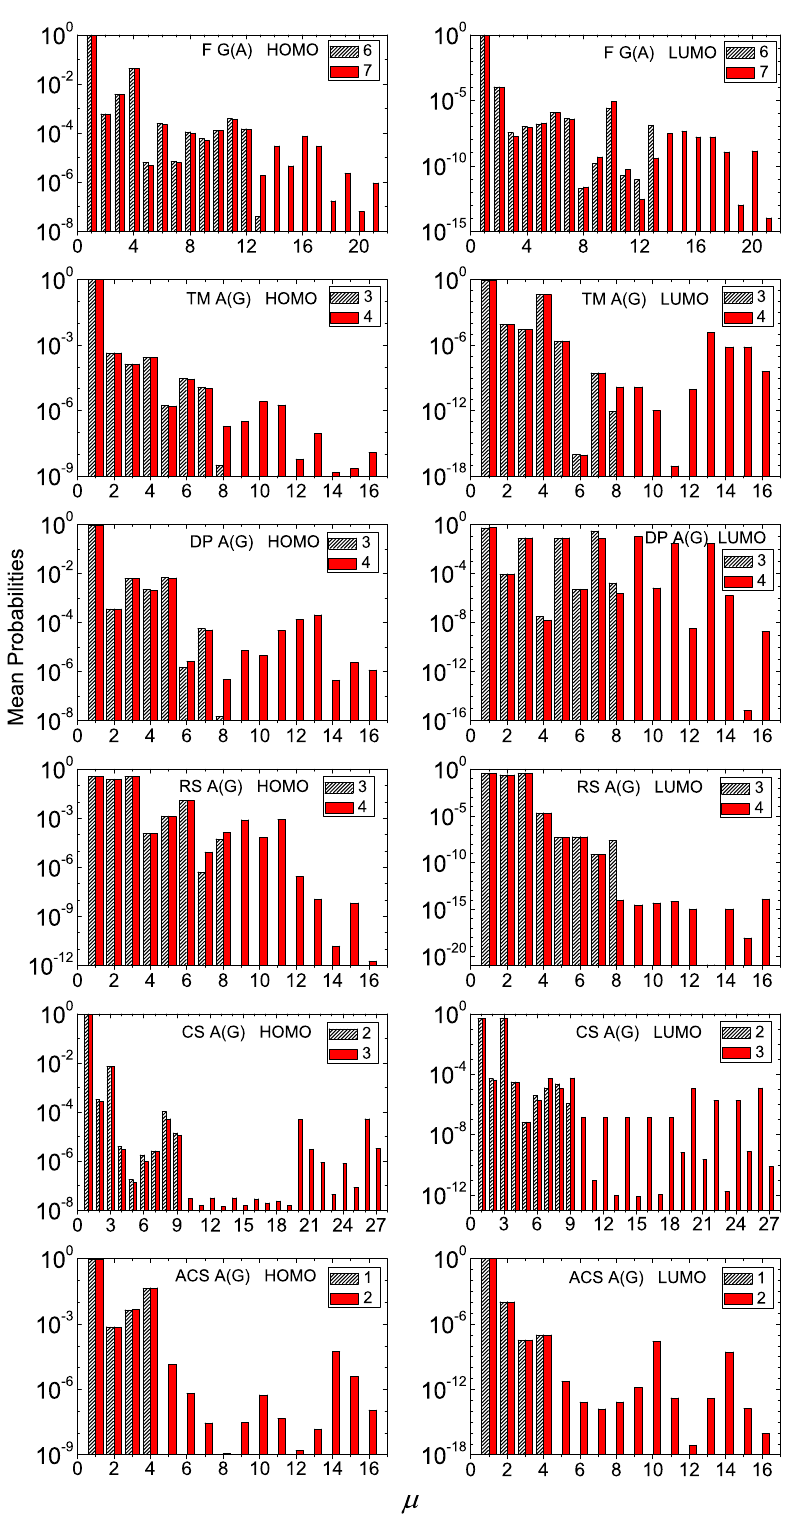
Figure 7. Mean over time probabilities to find the extra carrier at each monomer µ = 1, . . . , N , having placed it initially at the first monomer, for two consecutive generations (the number of which is denoted at each panel’s legend) for F G(A), TM A(G), DP A(G), RS A(G), CS A(G), ACS A(G) polymers, for HOMO (left column) and LUMO (right column). The notation of polymers is given in Table